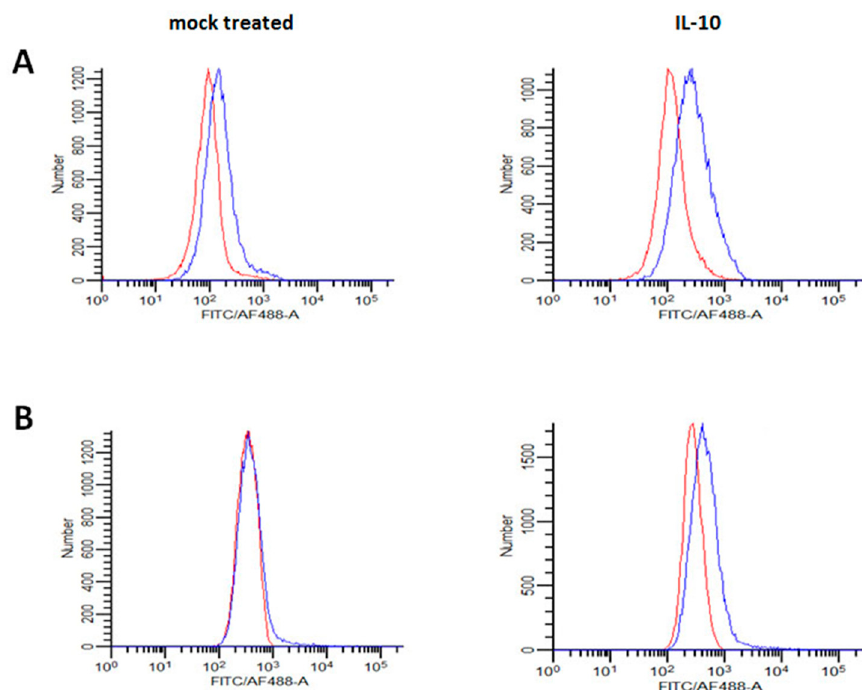
Figure 5. Increased binding of EBOV GP to IL-10 treated primary human MDM. ( A ) Cells were pre-treated for 48 h with IL-10 and incubated for 1.5 h at 4 °C in binding buffer (0.5% HSA in Ca 2+ and Mg 2+ containing DPBS) with a recombinant protein, consisting of the EBOV GP receptor binding domain (GP 1 residues 57 to 149), fused to the Fc portion of rabbit IgG. MDM incubated with the binding deficient construct 4merRBR-Fc served as a negative control (red line). Subsequently, the MDM were washed, labeled with FITC conjugated polyclonal goat anti-rabbit antibody, fixed with paraformaldehyde and analyzed by Flow Cytometry. The staining indexes for the mock and IL-10 treated pairs of negative and positive samples are 0.3593 and 0.7086, respectively (for details regarding the staining indexes calculation please refer to Material and Methods). ( B ) Alternatively, MDM were incubated for 2.5 h at 4 °C with GFP-containing (VP40-GFP) VLPs pseudotyped with full length EBOV Kikwit GP (blue line). Full length EBOV GP- pseudotyped VLPs, which do not contain GFP, served as a negative control (red line). The staining indexes for the mock and IL-10 treated pairs negative and positive samples are 0.8444 and 1.8228, respectively.